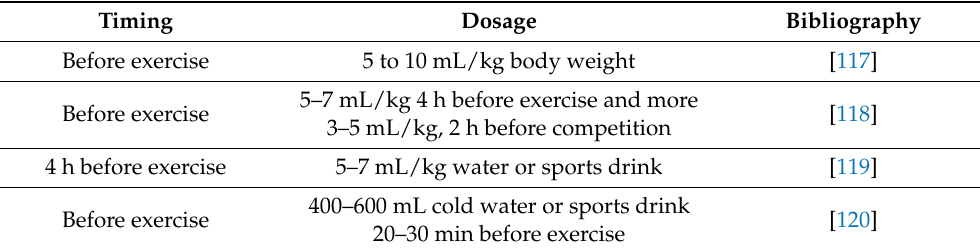
Table 6. Pre-exercise hydration dosages.